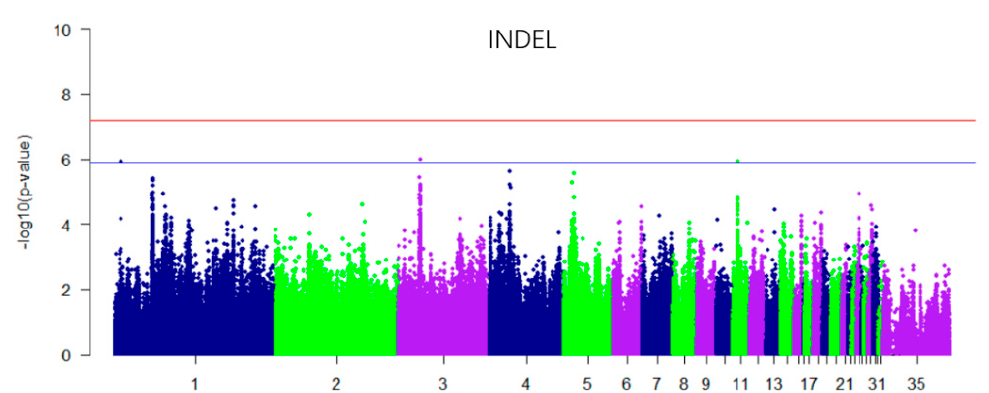
Figure 4. Manhattan plot derived from a GWAS (INDEL) at muscle glycogen. Each dot corresponds to an INDEL within the dataset, while the horizontal blue lines denote the suggestive significance thresholds (1.32 x 10 -6 ). The Manhattan plot contains –log 10 observed p -values for genome-wide SNPs (y-axis) plotted against their corresponding position on each chromosome (x-axis). Table 4. INDELs with genome-wide significance for glycogen traits.